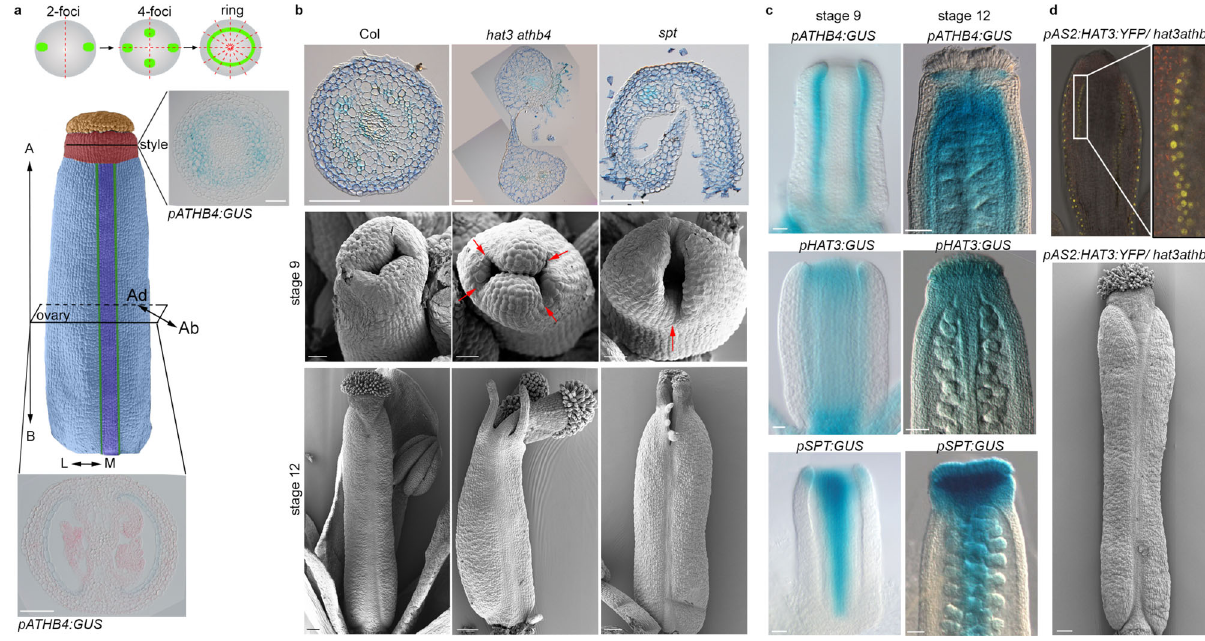
Fig. 1 HD-ZIP II proteins HAT3 and ATHB4 coordinate adaxial/abaxial polarity axis during symmetry transition. a Schematic representation of symmetry transition in Arabidopsis wild-type gynoecium (Col-0); (top) schematic indicating the dynamic distribution of the DR5rev::GFP signal in the outline of the gynoecium viewed from the top. Two-foci = bilateral symmetry — one plane of symmetry; four-foci = biradial symmetry — two planes of symmetry; ring = radial symmetry — ≥ 3 planes of symmetry; (bottom) false-coloured scanning electronic micrograph (SEM) of wild type at stage 11. Stigma (orange), style (red), valves (light blue), valve margins (green), replum (violet), including GUS-stained cross-sections of the pATHB4:GUS reporter shown for radially symmetric style (top) and bilaterally symmetric ovary (bottom). Scale bars represent 50 µ m. Double-headed arrows indicate the polarity axes: A apical, B basal, M medial, L lateral, Ab abaxial, Ad adaxial. b Optical images of Toluidine blue-stained cross-sections of stage-12 style (top panels; scale bars represent 100 μ m) and SEM images (middle and bottom panels) of Col-0 (left), hat3 athb4 (centre) and spt (right) at stage 9 (middle; scale bars represent 20 μ m) and stage 12 (bottom; scale bars represent 100 μ m). Red arrows indicate the different positions of the split style in the mutant backgrounds. c Optical images of GUS-stained gynoecia of pATHB4:GUS (top), pHAT3:GUS (middle) and pSPT:GUS (bottom) lines at stage 9 (left) and stage 12 (right) of gynoecium development. Scale bars represent 20 µ m (left, stage 9) and 50 µ m (right, stage 12). b , c Similar results were obtained from four independent experiments. Sections in ( a , b ) were made using samples from two of the four biological replicates in ( b , c ). d Confocal (top) and SEM (bottom) images of pAS2:HAT3:YFP/hat3 athb4 gynoecia at stage 9 (top) and stage 12 (bottom) of development. Scale bar represents 100 µ m. Similar results were obtained from three independent